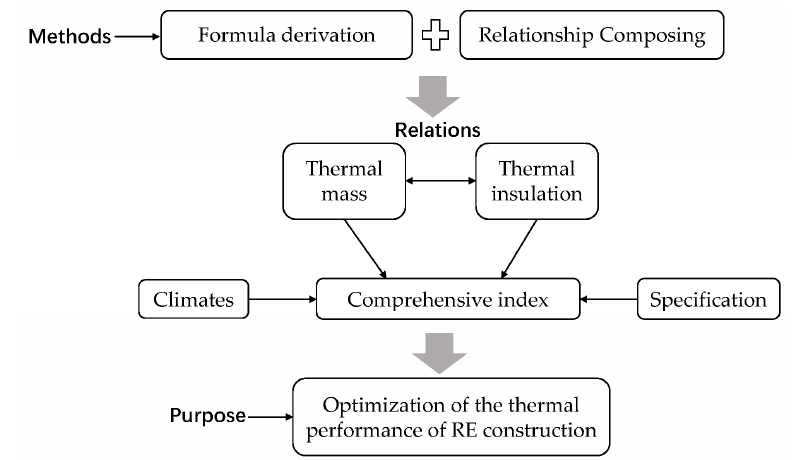
Figure 1. Technical route of the paper.